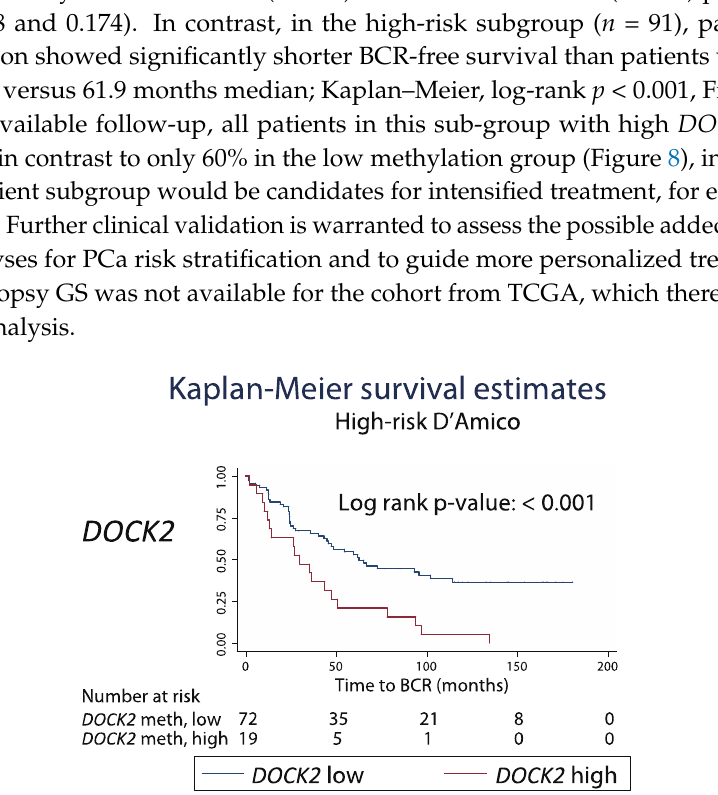
Figure 8. Kaplan–Meier plots with biochemical recurrence (BCR) as an endpoint in the subgroup of Danish PCa patients with D’Amico high-risk. Patients were divided into low and high methylation groups for DOCK2 based on the ROC curve analysis of the BCR status at 36 months post-RP. p -value from the log-rank test.